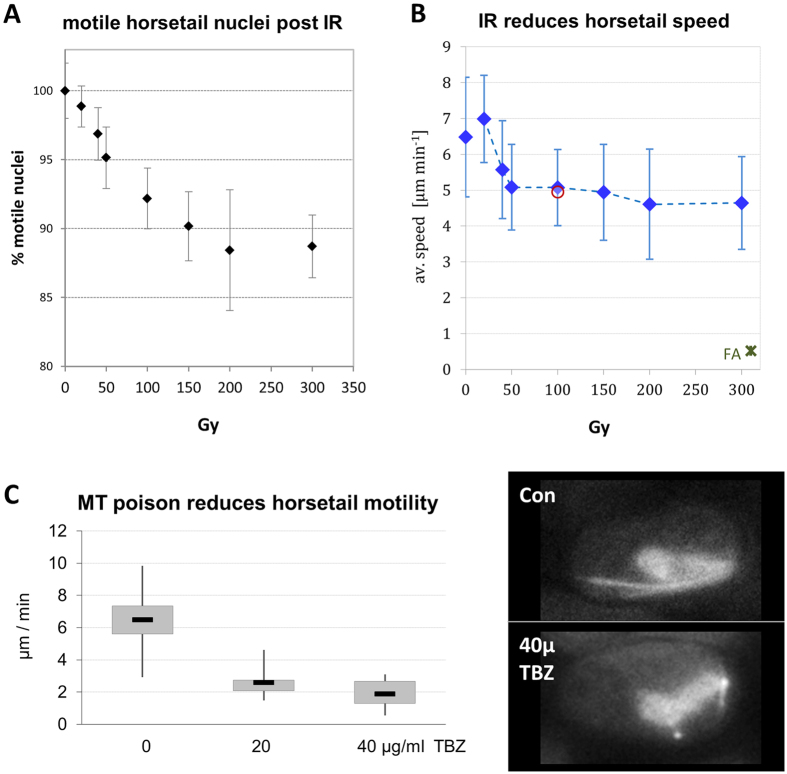
Dose-dependent reduction of horsetail mobility by X ray exposure.(A) Irradiation with doses of up to 200 Gy leads to a linear reduction (r2 = 0.937) of the number of mobile horsetail nuclei per sporulating culture. Beyond 200 Gy there was no further effect. Data points reflect the mean of 3 experiments (±SD). (B) X irradiation significantly reduces average horsetail speed at ≥50 Gy (p < 0.0001) relative to control, while there is only a slight insignificant further reduction up to 300 Gy, indicating that MT-driven horsetail mobility is radioresistant. Controls: The red circle indicates the horsetail speed of cells in sporulation medium without minerals and vitamins after irradiation with 100 Gy, to test for nutrient effects on speed measurements. The dark-green asterisk at the lower right (FA) indicates the mobility of the leading edge of the horsetail nuclei after 4% formaldehyde fixation. (C) Effect of the MT-poison TBZ on horsetail mobility. Treatment of sporulating culture with TBZ (20 and 40 μg/ml TBZ) lead to a highly significant (p < 0.001) reduction of horsetail speed. The images to the right display a control cell (Con; nuclear equator shown) and a cell treated with 40 μg/ml TBZ (40 μ TBZ) that exhibits the loss of long astral microtubules. Box blot, whiskers show minimum and maximum speed observed.